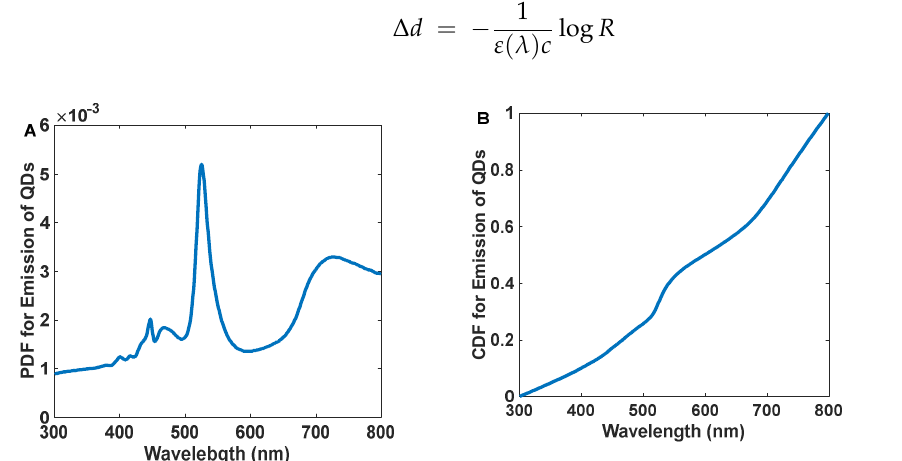
Figure 9. Probability density function (PDF) and cumulative distribution function (CDF) for emission spectrum of core-shell SiO 2 -silicon nanoparticle ( A , B ), respectively.